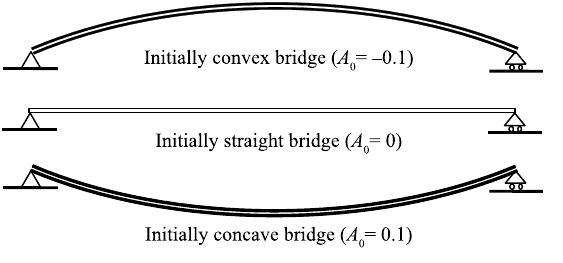
Fig. 2. Convex, straight and concave bridges